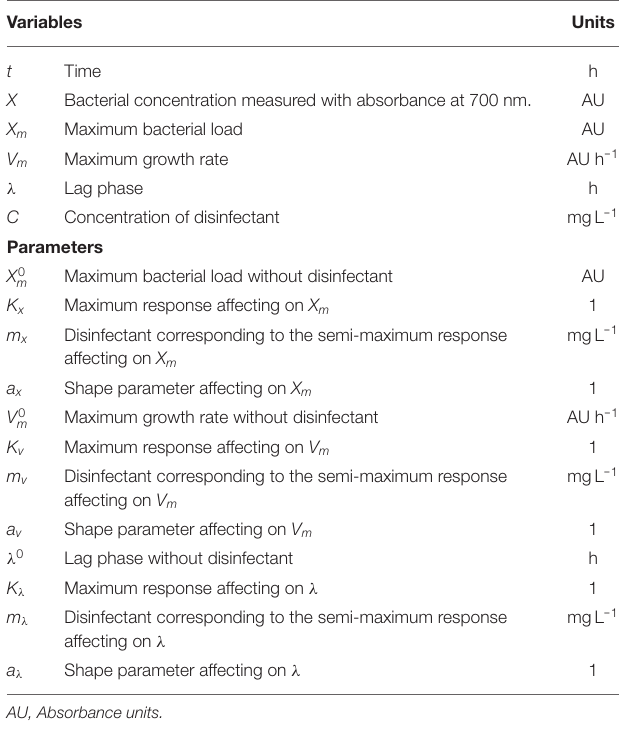
TABLE 1 | Variables and parameters used for the logistic model. Variables